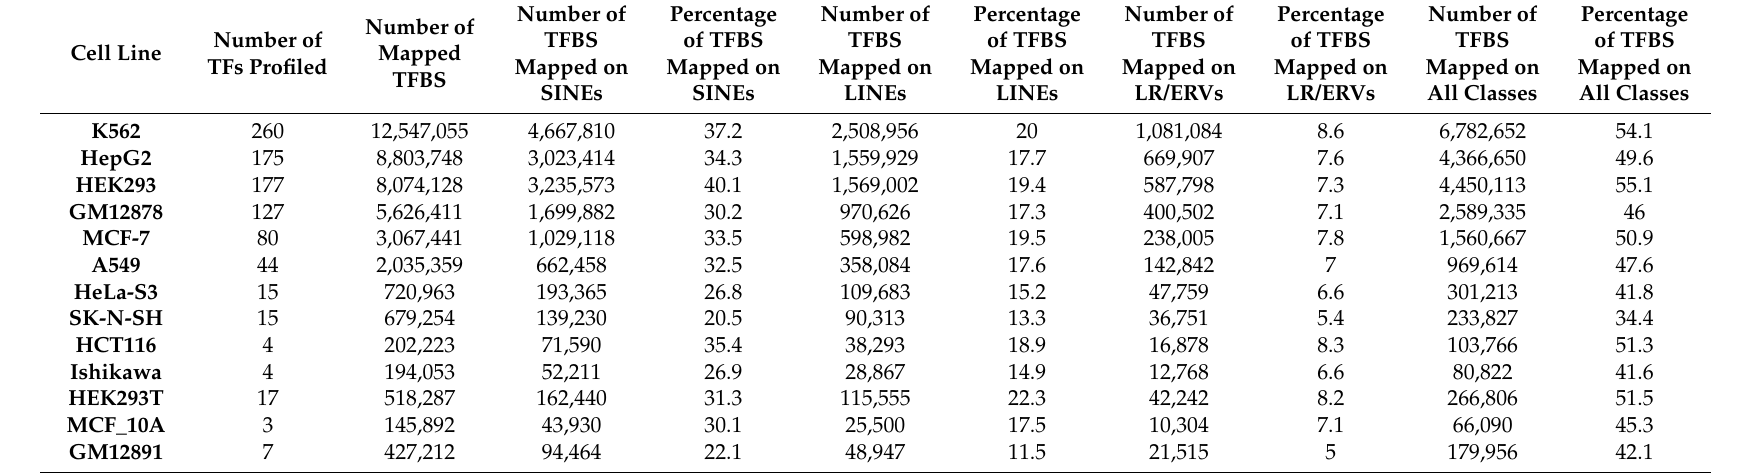
Table 2. Gene neighborhood-linked TFBS